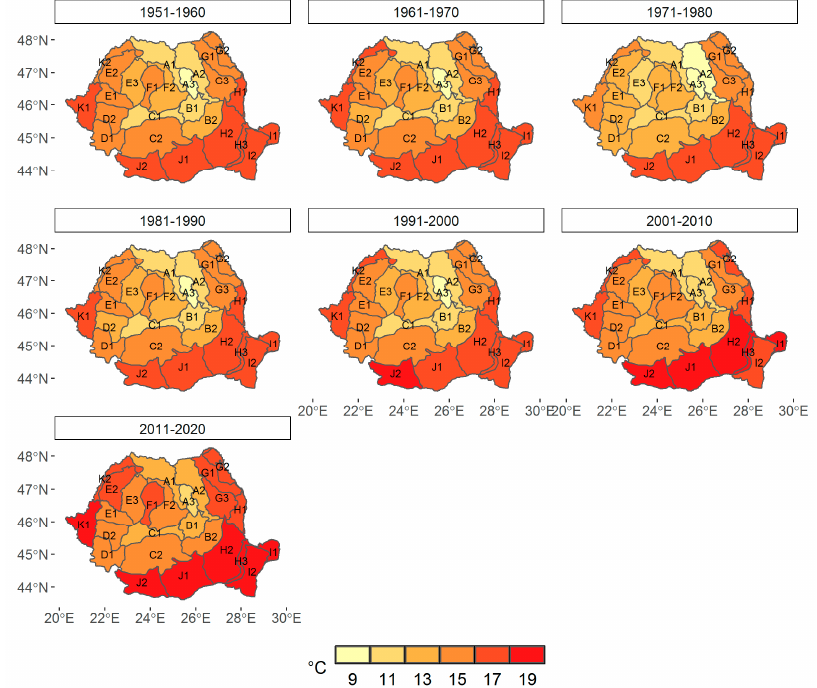
Figure 6. The variation of MT VS on the decades for the provenance subregions.